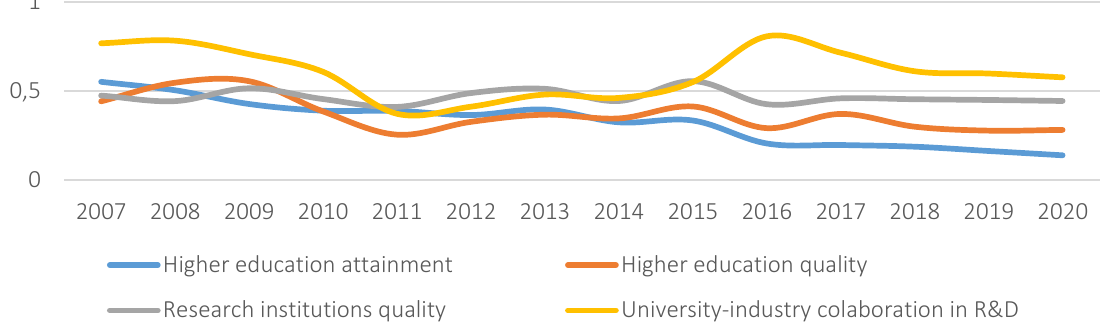
Figure 2. Higher education systems’ skewness (152 countries, 4 indicators characterizing the national higher education systems) over the last decade, 2018–2021 – linear trend line